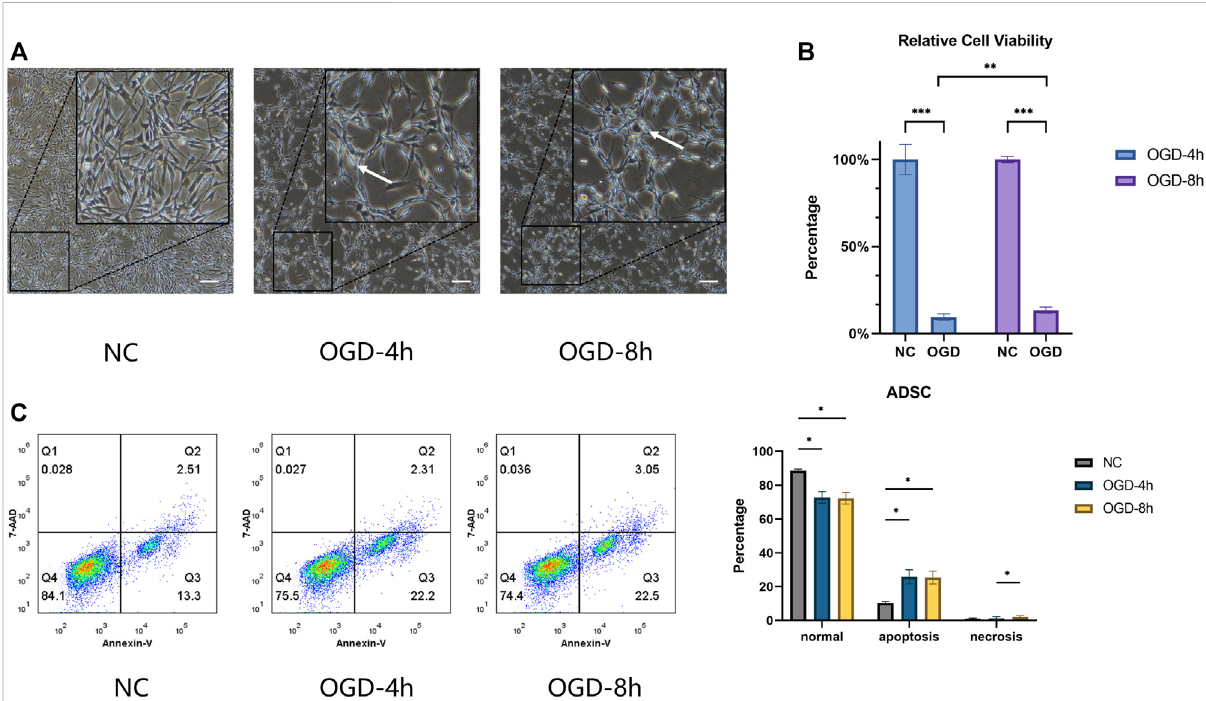
FIGURE 1 (A) Optical microscope morphology of ADSCs after normal culture and OGD treatment at different times. The round cells marked by arrows indicatethatthecellsare fl oating,suggestingthatcellproliferationisaffected,unabletoadheretothewellnormally,andconcomitantcelldeathmay occur. Scale bars = 200 µm. (B) ADSCs under OGD for 4 h and for 8 h represent relative cell viability of 9.52 ± 1.50% and 13.53 ± 1.76%, respectively. Signi fi cant differences were observed within the two subgroups compared with the control group and between the OGD-4 h and OGD-8 h groups. (C) The percentage of cells within the NC, OGD-4 h and OGD-8 h groups in the lower left (normal) quadrant was 88.57 ± 0.99%, 72.80 ± 3.46%, and 72.47 ± 3.44%, in the lower right (apoptosis) quadrant was 10.35 ± 0.83%, 25.93 ± 4.15%, and 25.40 ± 3.80%, and in the upper